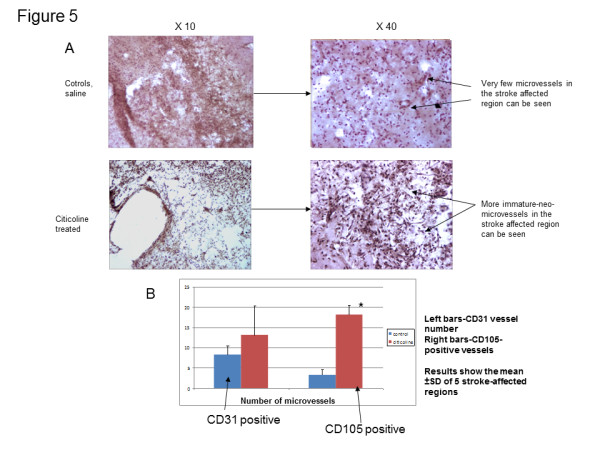
Immunohistochemical staining for CD31 demonstrated a trend for increased numbers of total microvessels in stroke regions of rats treated with citicoline following MCAO. A) Treatment with citicoline increased the number of CD31-positive microvessels (total number of vessels but did not reach significance) in the peri-infarcted and infarcted regions following transient rat MCAO after 21 days. The figure shows citicoline-treated animals (top row) versus saline treated controls (bottom row). Sections were immunohistochemically stained and developed using DAB (brown). Arrows point to CD31-positively stained microvessels which were morphologically more immature (thinner walls and less pericyte coverage) present in larger numbers in each animal studied following citicoline treatment (n = 3). B) Bar chart showing the increase in CD31 positive and CD105 positive vessels stained in sections (5 analyzed per animal) from rats following transient MCAO and treatment with citicoline as described in the methods section (n = 3 in each group).